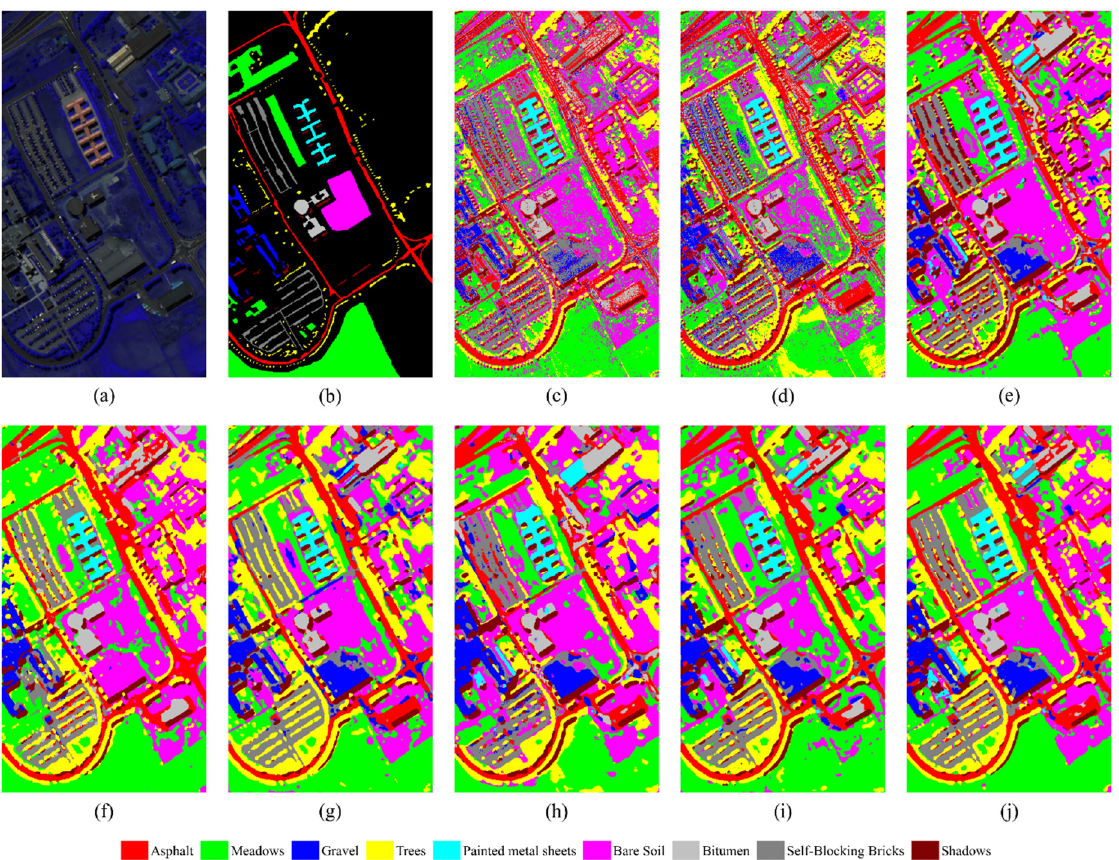
Figure 5. Classification maps of the different models for PU data set: ( a ) False-color image. ( b ) Ground-truth. ( c ) SVM ( d ) MLP ( e ) pResNet. ( f ) SCFR-CNN. ( g ) SSRN. ( h ) SSDC. ( i ) FDSSC. ( j ) DPSCN.